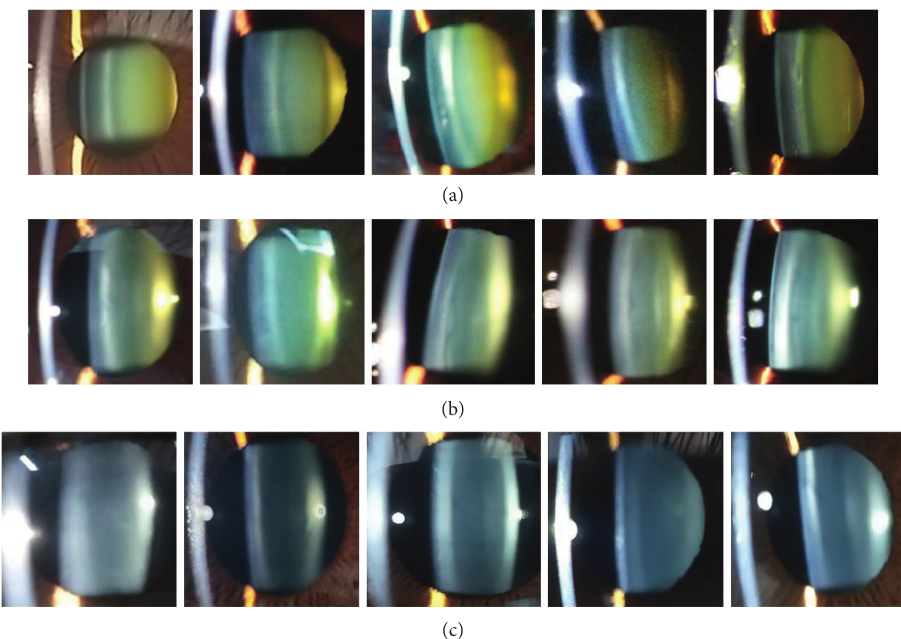
Figure 7: Example diagram of smartphone slit-lamp judging the category of eye